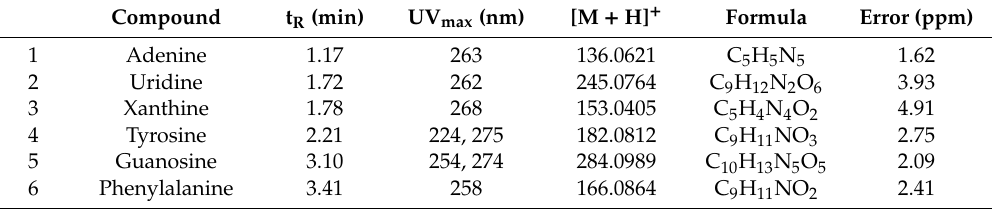
Table 1. Nitrogen compounds identified in the investigated honey